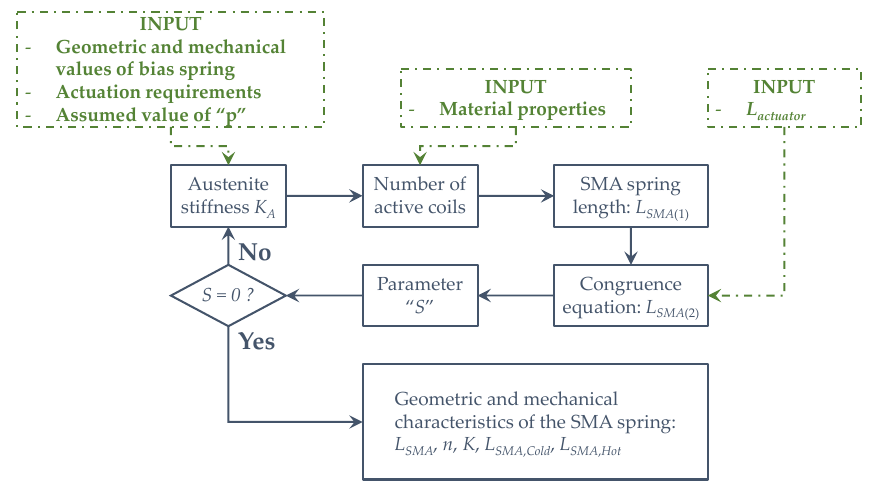
Figure 4. Design framework.